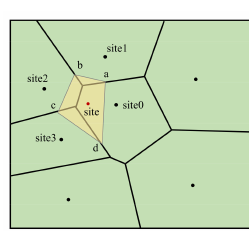
Figure 9. The improved Voronoi diagram algorithm. a, b, c and d represent the intersection of the new Voronoi cell with the original Voronoi